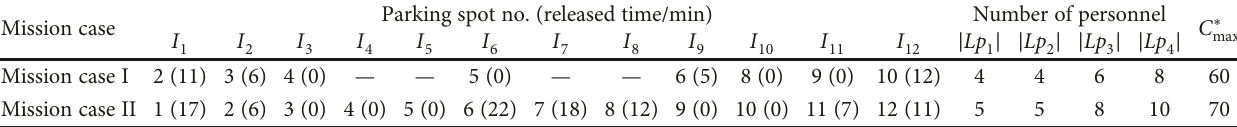
Table 8: Information related to di ff erent mission cases.